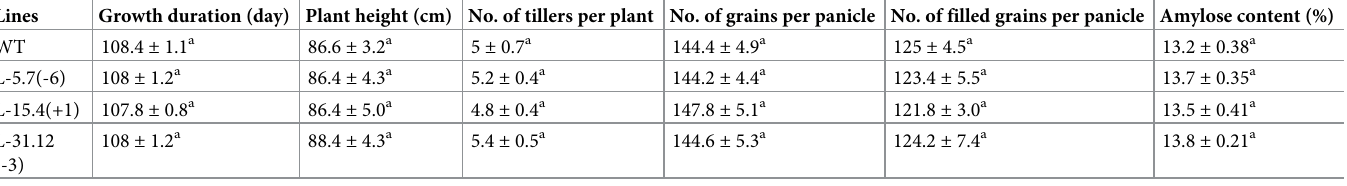
Five plants per line were measured. Experiments were repeated three time. Means followed by the same letter do not differ significantly ( P <